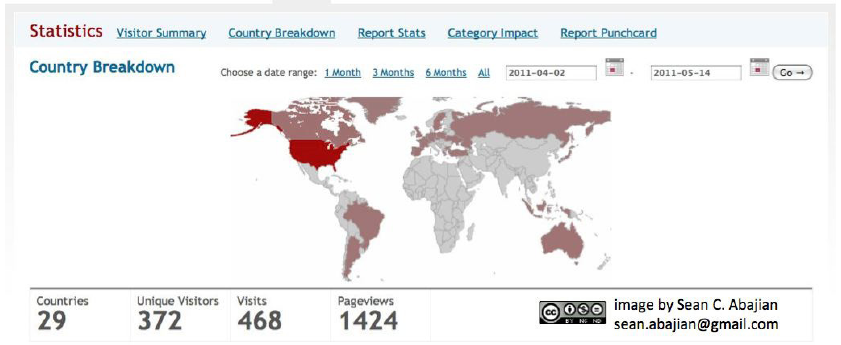
Figure 6 . Overview of people accessing the social media tool MobiMOOC from